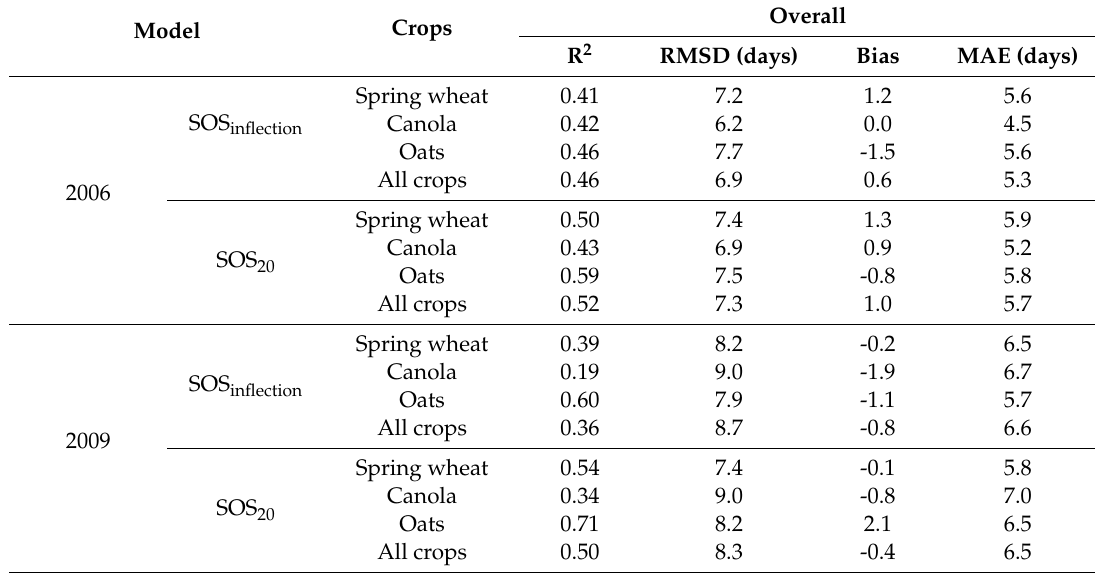
Table 4. Accuracy assessment of the estimated seeding date from remotely sensed SOS using R 2 , RMSD, bias and Mean Absolute Error (MAE). Model Crops